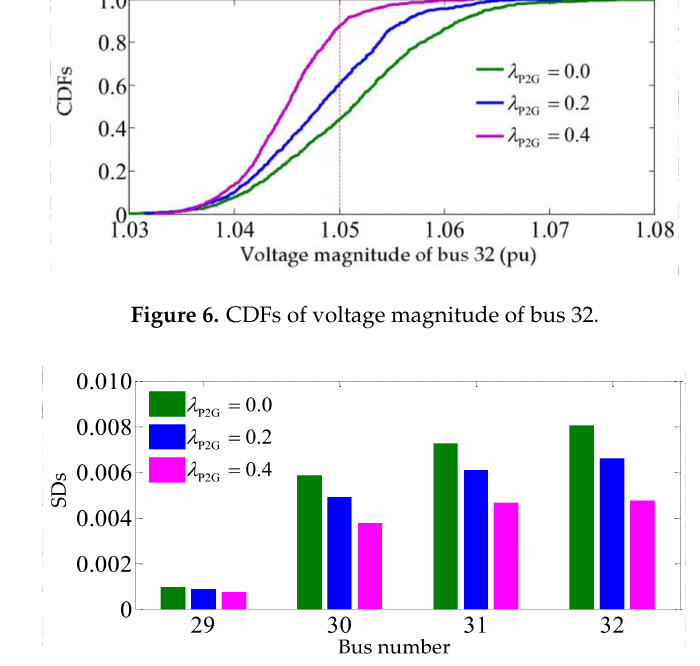
Figure 7. SDs of voltage magnitudes of buses 29–32.